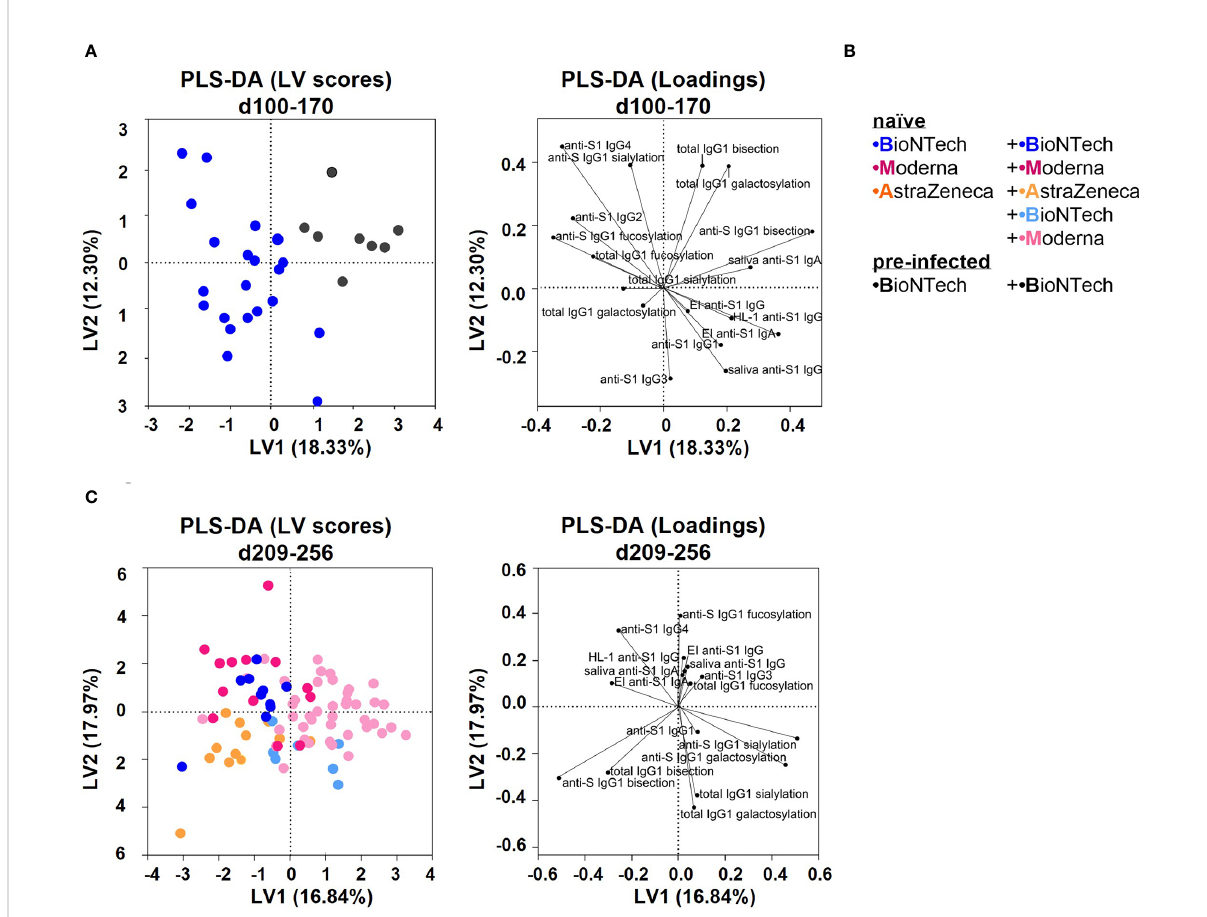
FIGURE 7 Partial least squares-discriminant analysis (PLS-DA) of the study groups (A) PLS-DA of data collected from the naïve and pre-infected B+ (B) vaccination cohorts between day (d) 100 and 170 upon fi rst vaccination. Latent variable (LV) scores and loadings are shown. The area under the receiver operating characteristic curve (AUROC) for cross-validation is 0.8810 for both groups. (B) Color legend of the six vaccination groups. (C) PLS-DA of data collected from all naïve vaccination cohorts between day (d) 209 and 256 upon fi rst vaccination. The AUROC values for cross-validation are B+B: 0.8304, M+M: 0.8449, A+A: 0.7416, A+B: 0.8773, and A+M: